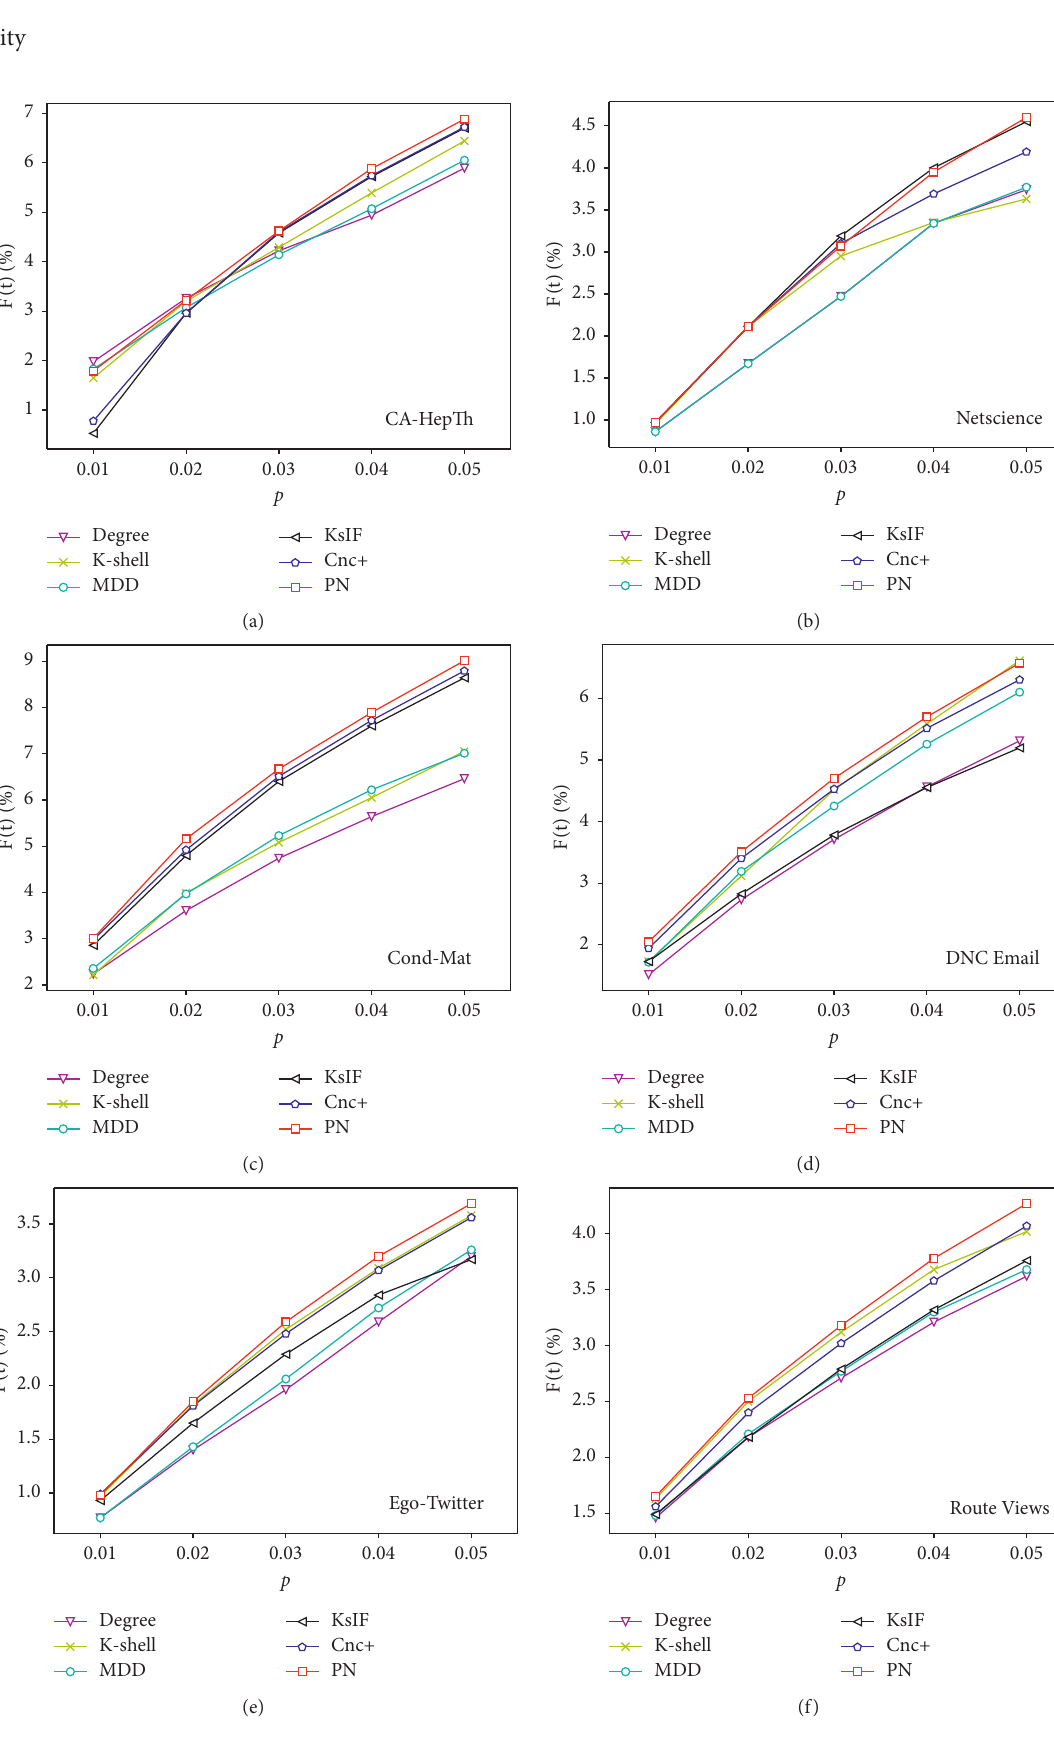
Figure 6: The performance of selecting seeds of the six methods in influence maximization problem. The experiments are simulated on six different datasets: CA-HepTh (a), Netscience (b), Cond-Mat (c), DNC Email (d), Ego-Twitter (e), and Route Views